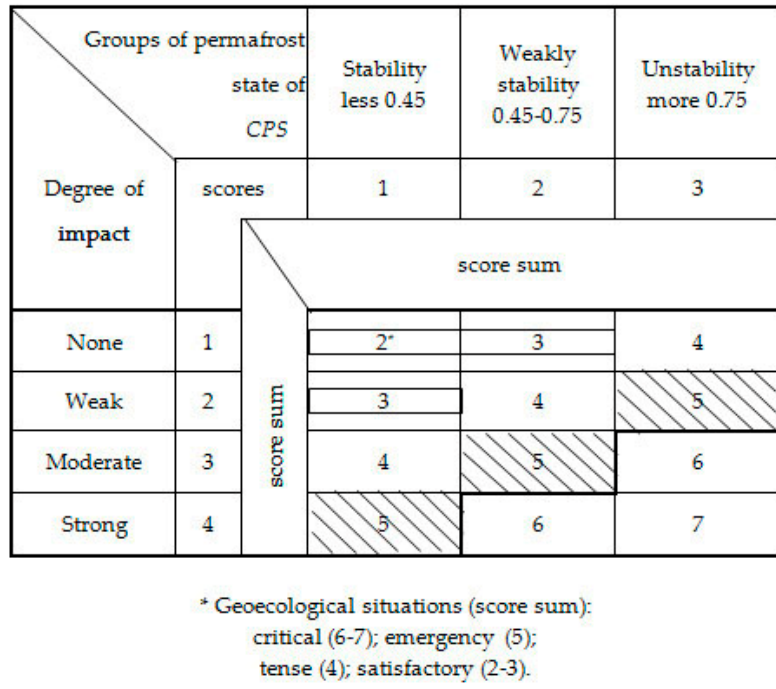
Figure 9. Matrix table of Geoecological Situations map.